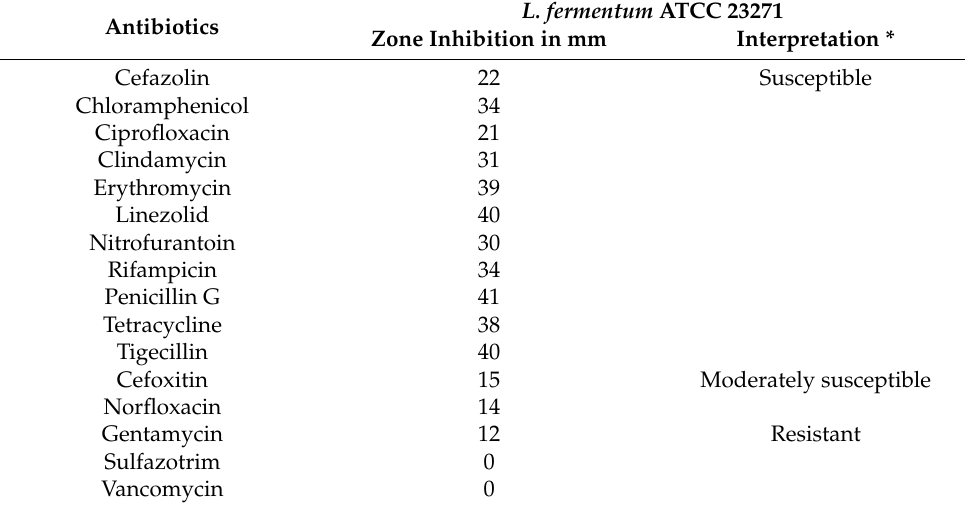
Table 8. L. fermentum ATCC 23271 antimicrobial susceptibility by the disc diffusion method. Antibiotics Zone Inhibition in